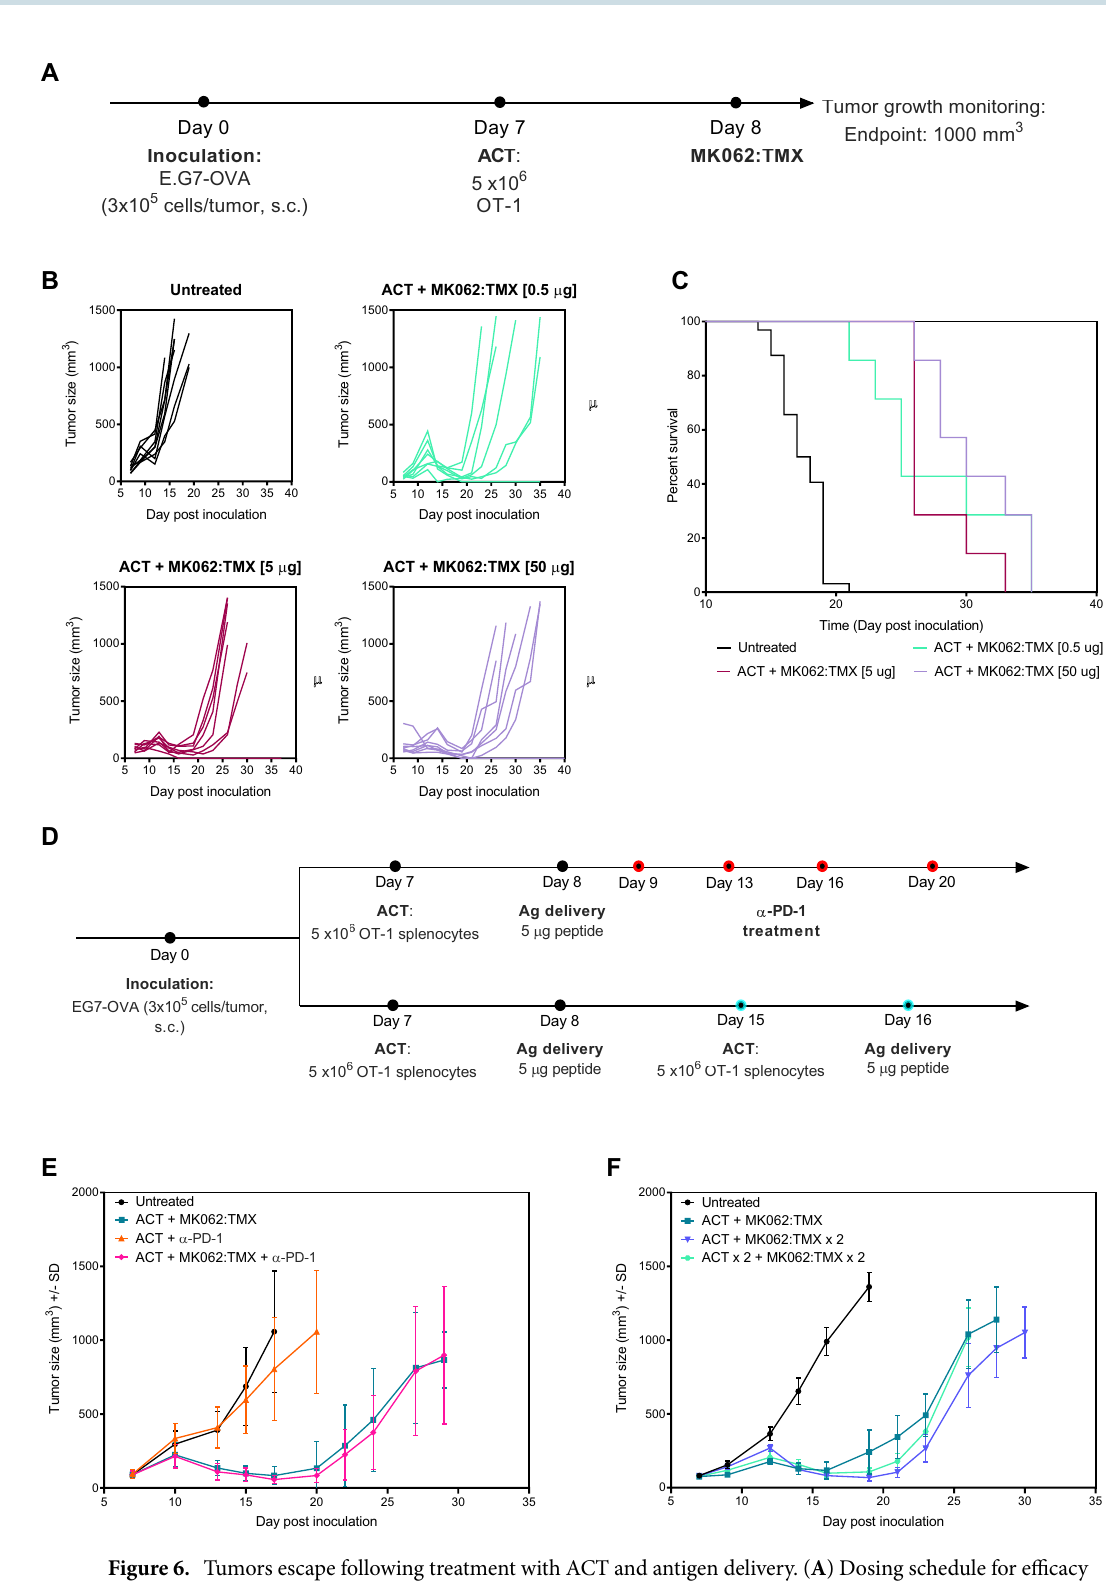
Figure 6. Tumors escape following treatment with ACT and antigen delivery. ( A ) Dosing schedule for efficacy studies. ( B ) Individual tumor growth curves. ( C ) Survival plots. ( D ) Dosing schedule for efficacy studies using either α-PD-1 treatment (top) or additional T cell infusion and/or antigen delivery (bottom) as interventions. ( E ) Tumor growth curves of mice treated with ACT + antigen delivery + α-PD-1. ( F ) Tumor growth curves of mice treated with two doses of ACT and/or antigen